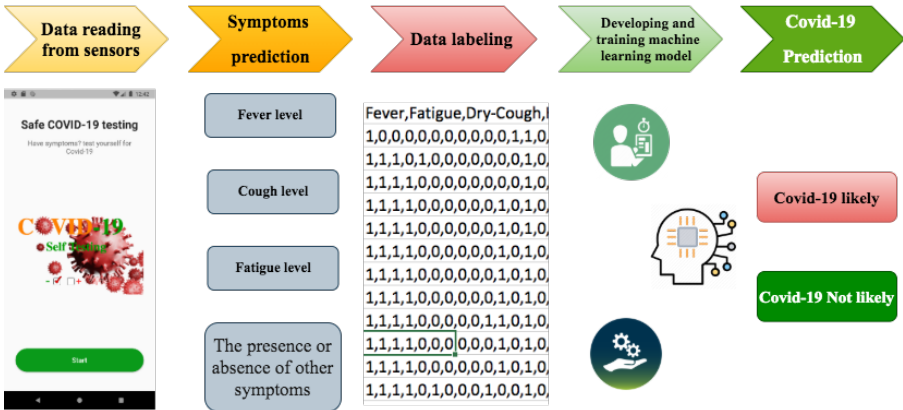
Figure 2. A diagrammatic representation of the proposed system for predicting